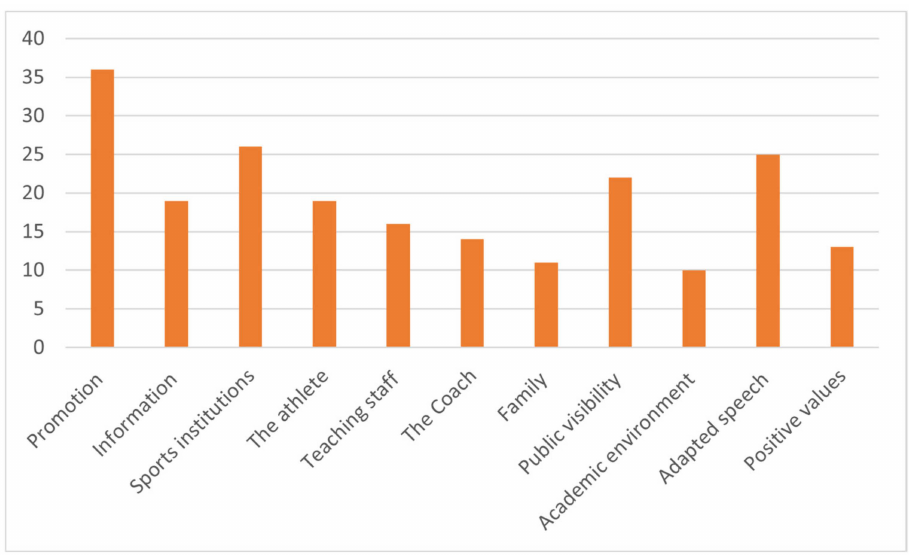
Figure 3. Distribution of specifications for “mass -media” category.